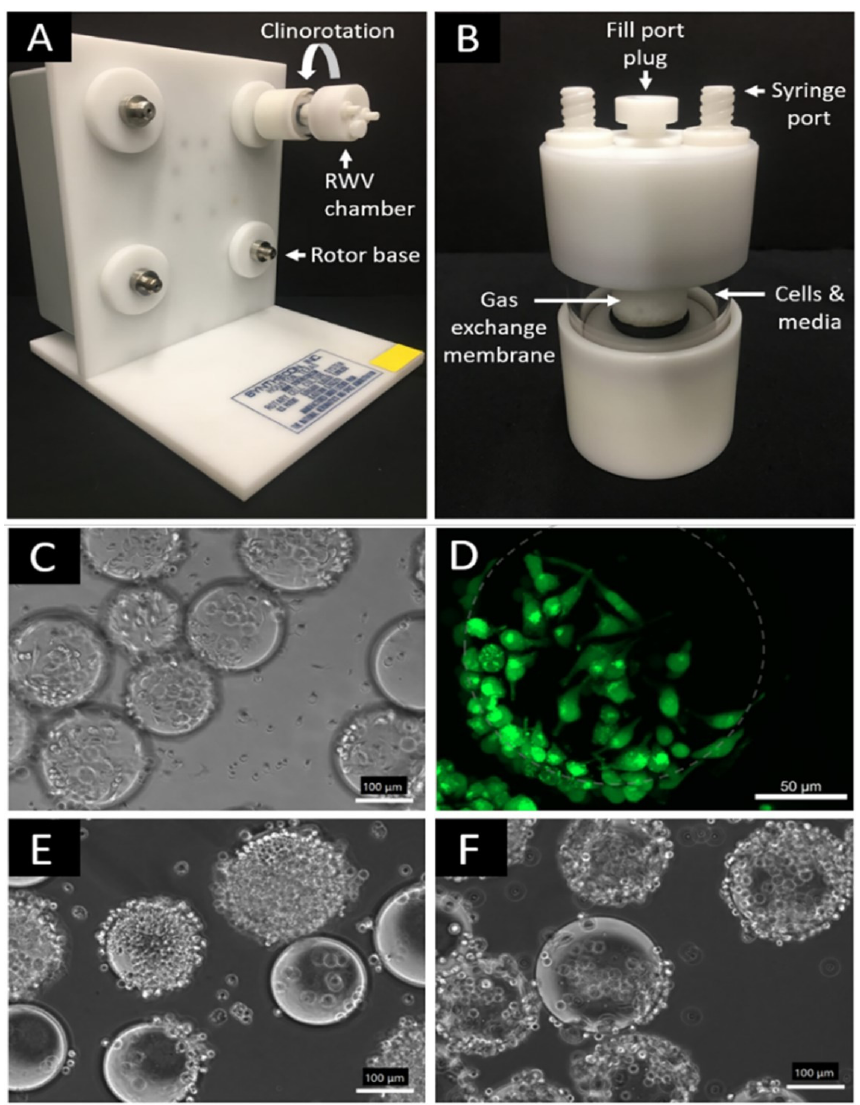
Figure 2. Rotary Cell Culture System Rotating Wall Vessel (RWV) bioreactor and representative microscopy images of RAW 264.7 macrophage cells on microcarrier beads. ( A ) RWV bioreactor base; ( B ) RWV bioreactor detachable vessel chamber; ( C ) M2 macrophage phenotype after 2-day attachment and polarization period (scale bar 100 µm); ( D ) Calcein-stained M2 macrophage cells after 2-day attachment period; dotted grey circle to approximate underlying bead for visual clarity (scale bar 50 µm); ( E ) 1G normal gravity control M2 macrophages (scale bar 100 µm); and ( F ) simulated µG M2 macrophages after 3-day period in RWV chambers (scale bar 100 µm).